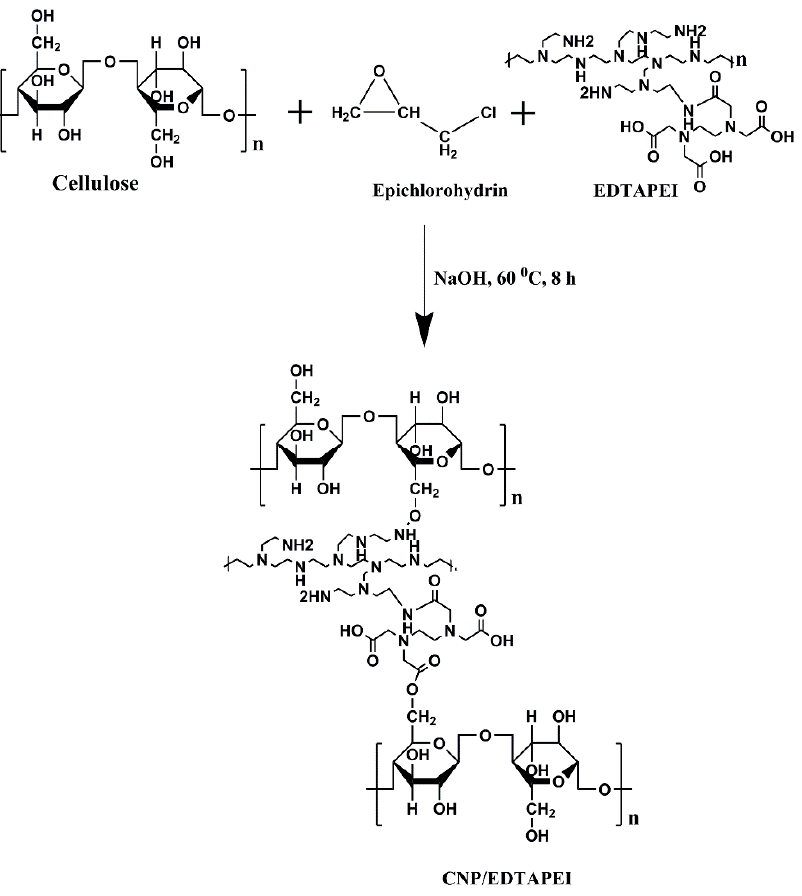
Figure 1. Schematic representation of CNP/EDTAPEI.